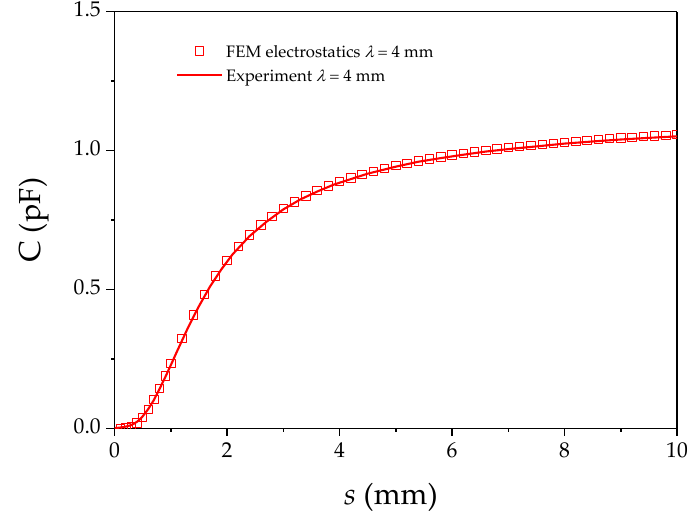
Figure 6. Simulated experiment based on the dimensions from the IDS cross sectional record via SEM and their permittivities. Incorporating these in FEM can accurately describe the practical environment.